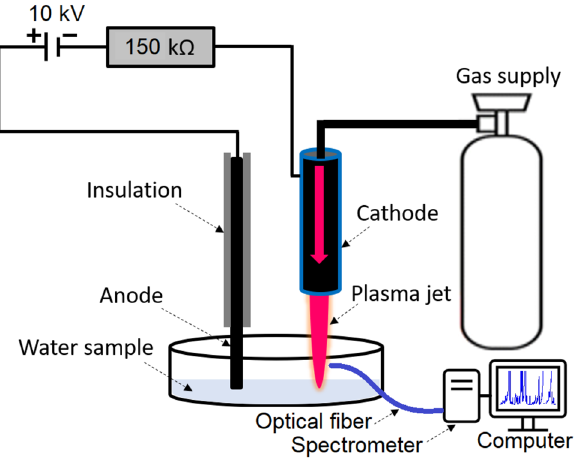
Figure 1. Schematic of DC plasma jet and associated optical emission spectroscopy